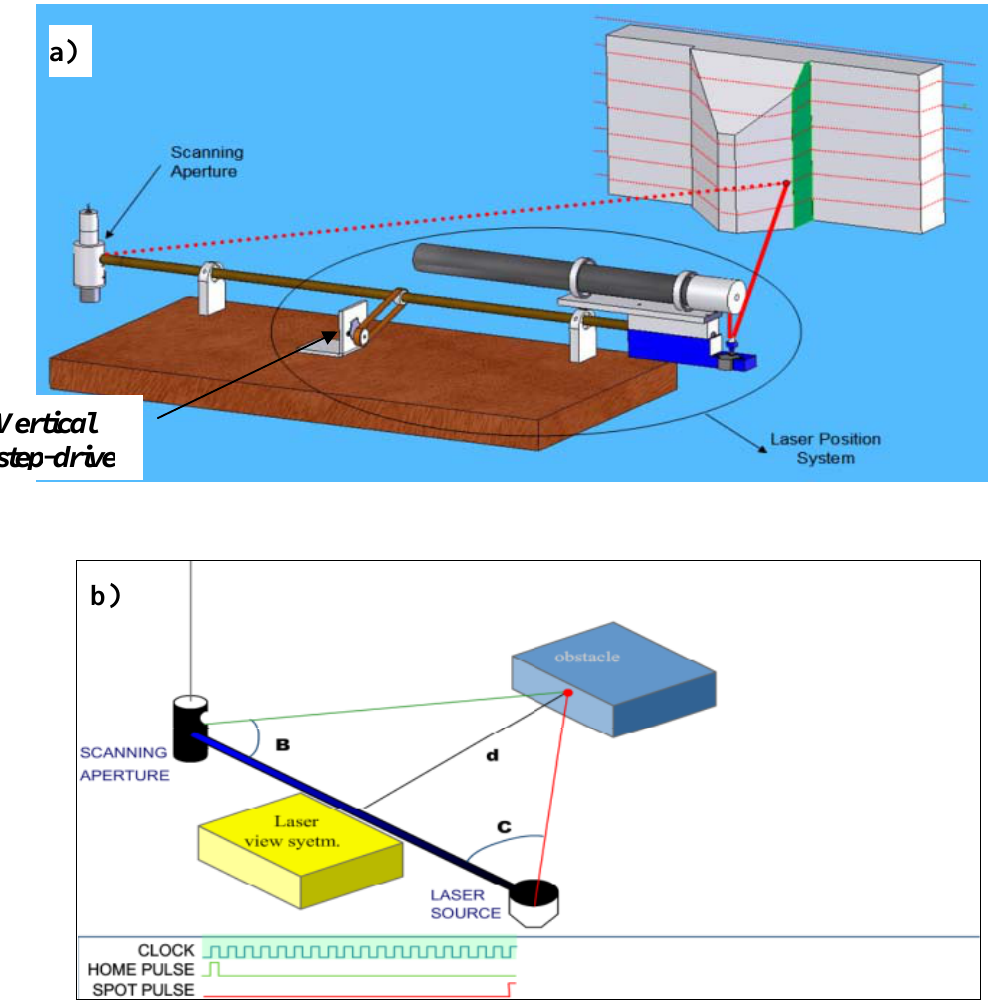
Figure 5. POS and LPS placement for automatic navigation task. a) General view of the system with interaction of the parts in functioning. b) Triangulation angles distance and signals from sensors and reference f (“clock”